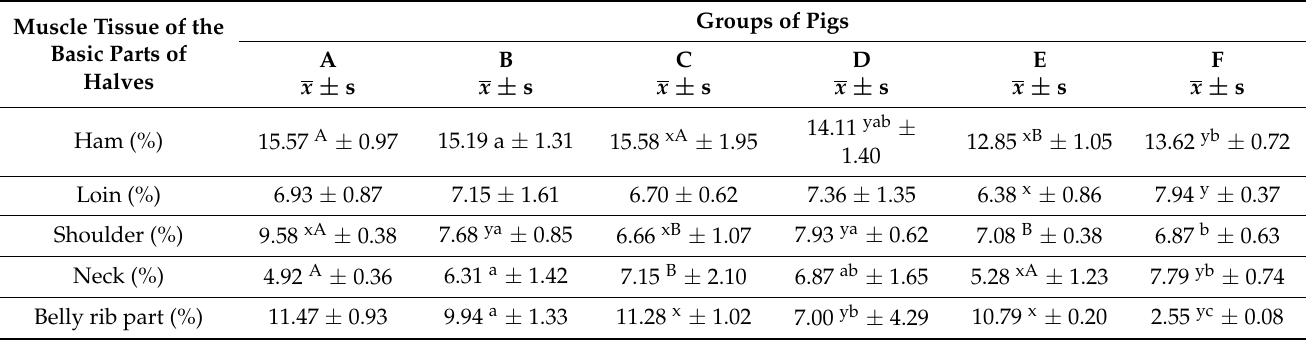
Table 6. Shares of muscle tissue of the basic parts in the weight of the pig carcasses.